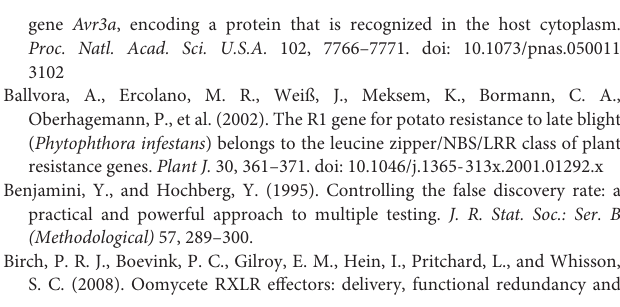
Supplementary Figure 3 | Expression patterns of kinase-encoding